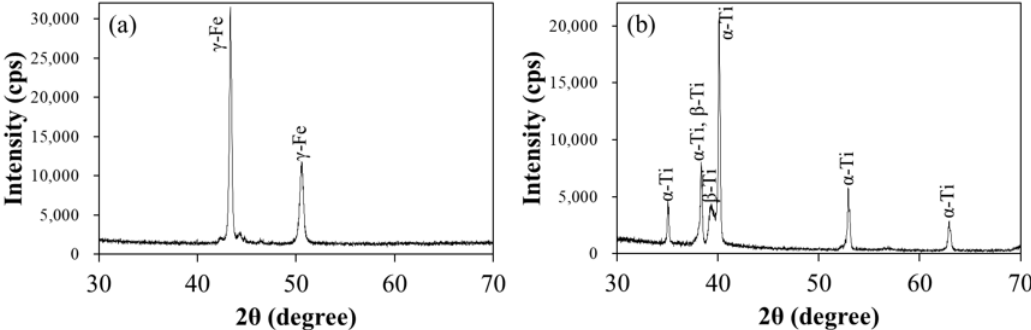
Figure 9. XRD spectra obtained from the fracture surfaces of the ( a ) 304 stainless-steel side and the ( b ) CP-Ti side of the joint that was bonded at 970 °C, with an axial pressure and a bonding time of 30 MPa and 15 s, respectively.